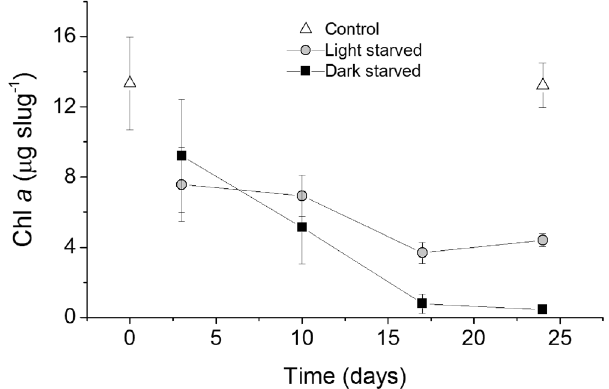
Figure 5. Changes in chlorophyll (Chl) a content of Elysia viridis with light and starvation. Chl a (mean ± standard deviation, n = 3) of animals feeding on Codium tomentosum (control), and starved under a 14:10 h light:dark cycle (light-starved) and in continuous darkness